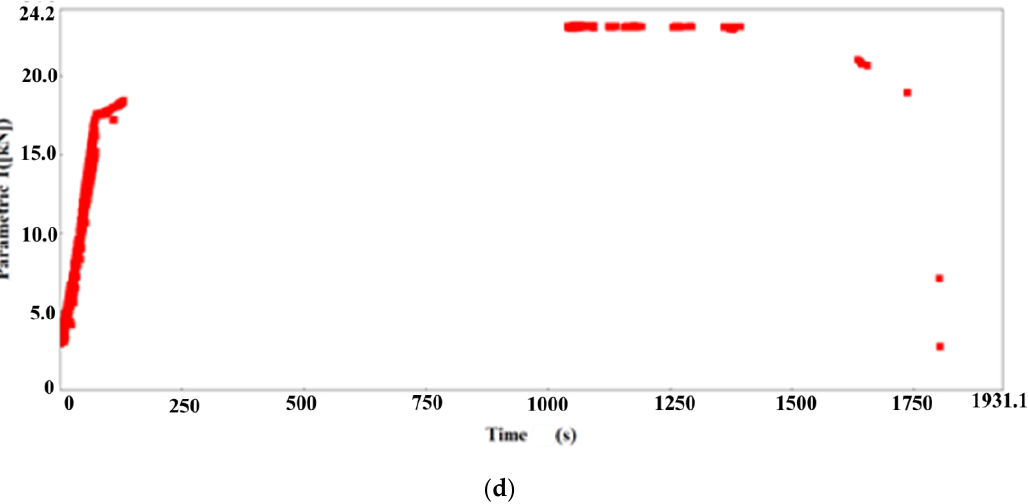
Figure 4. Signals recorded for the individual sensor types: ( a ) VS12-E; ( b ) VS75-SIC-40dB sensor; ( c ) VS150-RIC sensor; ( d ) VS900-RIC sensor.